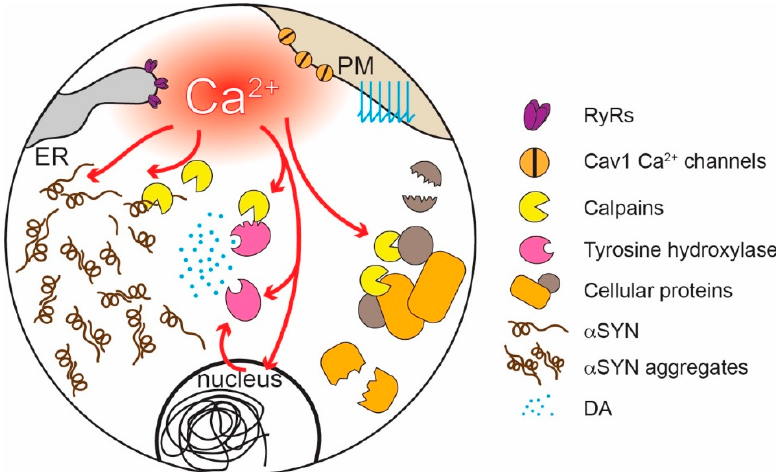
Figure 3 . Toxic effects of elevated [Ca 2+ ] in SN DAergic neurons. The engagement of Cav1 channels in pacemaking and the release of Ca 2+ through RyRs generate elevated cytosolic Ca 2+ levels that increase α -synuclein ( α SYN) aggregation, directly or through the activation of calpains; Ca 2+ -activated calpains can also damage several intracellular proteins. Ca 2+ and calpain cleavage can increase or dysregulate tyrosine hydroxylase activity and DA production, and DA oxidation can favor the aggregation of α SYN.